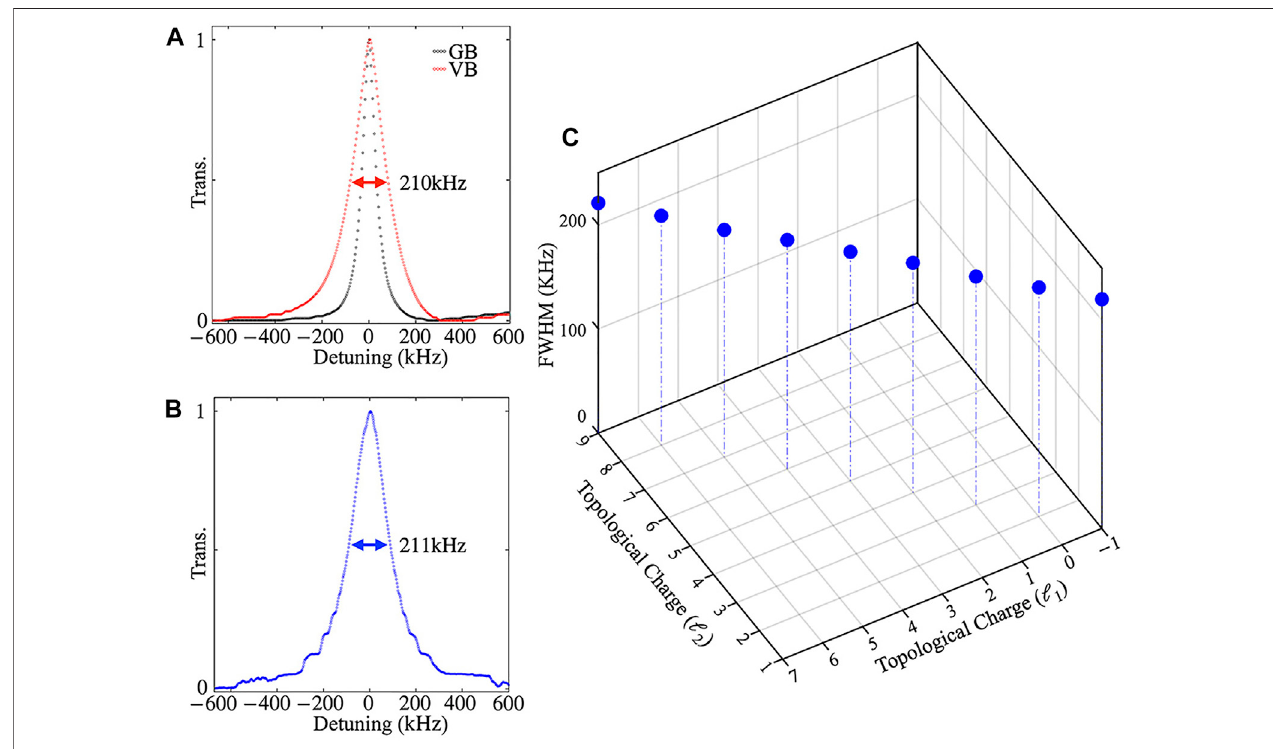
FIGURE 3 | FWHM depending on topological charge as a function of the total Zeeman shift δ (cid:1) 2g μ B | B | . (A) The transmission spectrum of Gaussian beam (GB) and vector beam (VB) with ℓ 1 (cid:1) − 1 and ℓ 2 (cid:1) 1; (B) The transmission spectrum of vector beam with ℓ 1 (cid:1) 7 and ℓ 2 (cid:1) 9; (C) FWHM of different asymmetric VB. One asymmetric VB brings two OAMs with unequal quantum number absolute value | ℓ 1 | ≠ | ℓ 2 | . And the difference (| ℓ 2 − ℓ 1 |) of these asymmetric VBs are equal, namely − ℓ | (cid:1) | ℓ 2 1